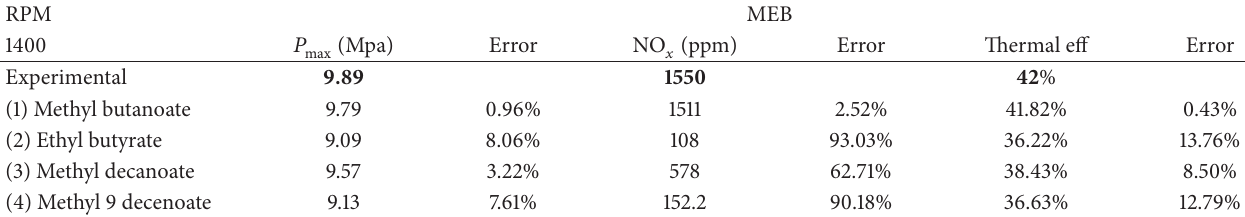
RPM Experimental